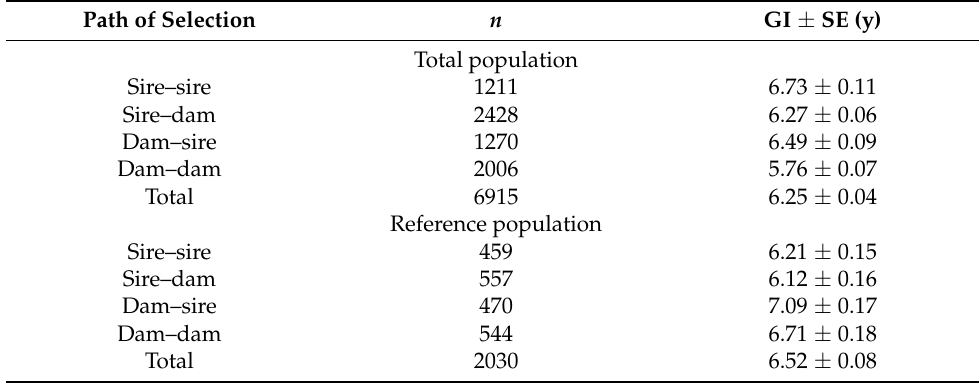
Table 1. Estimates (± SE) of generation interval (GI) for the four selection paths in Mexican Romosinuano beef cattle.